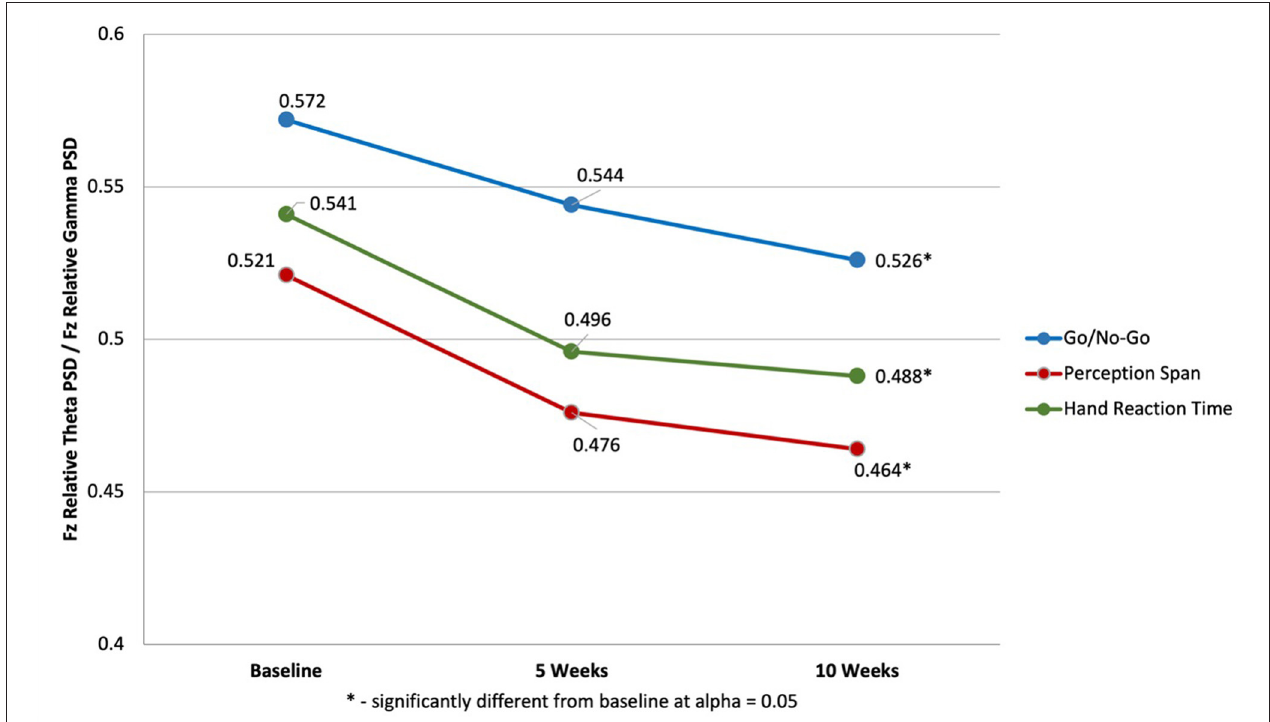
FIGURE 3 | Changes in Short-term Memory Load Index on Visuo-Motor Control measures of Go/No-Go, Perception Span and Hand Reaction